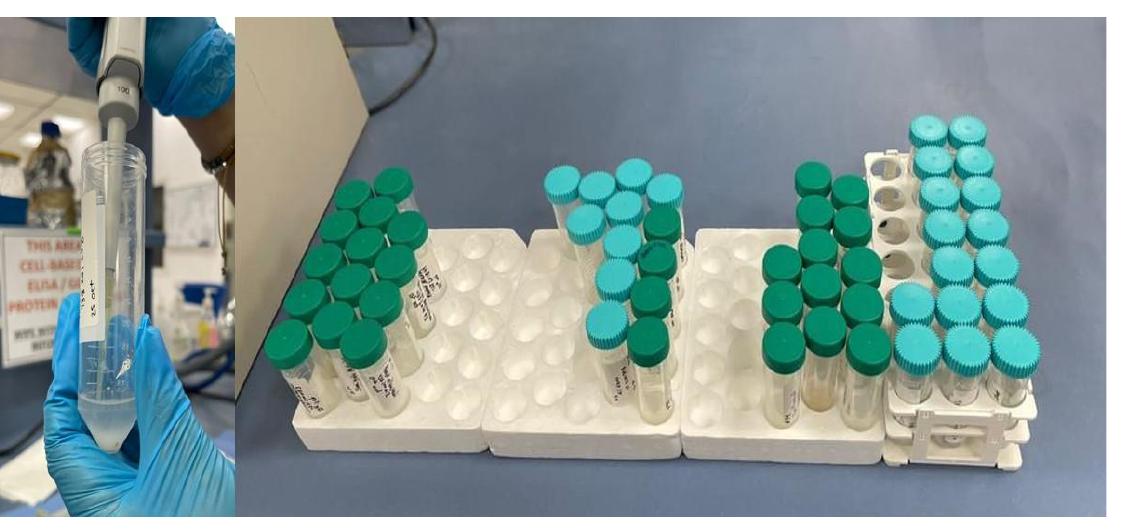
Figure 1. Salivary samples collection in test tubes.